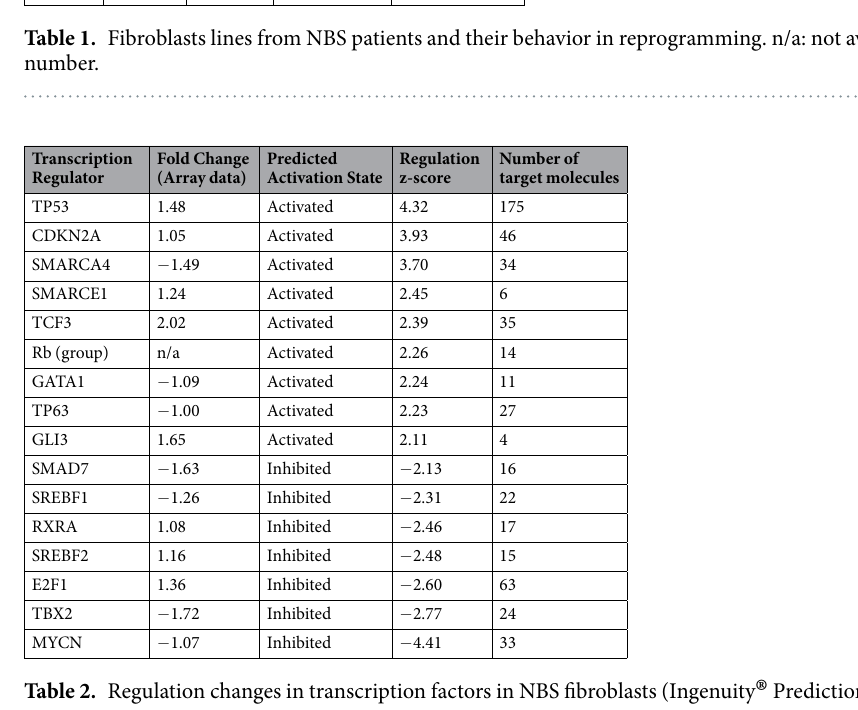
Table 2. Regulation changes in transcription factors in NBS fibroblasts (Ingenuity ® Prediction